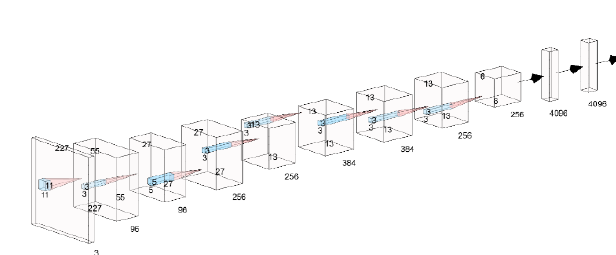
Figure 5. Convolution process of AlexNet